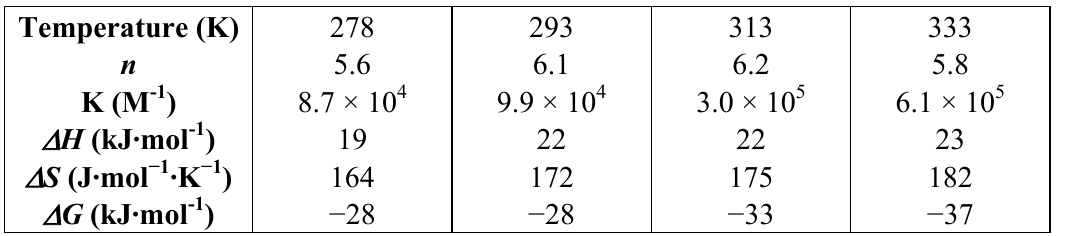
Table 1. Thermodynamic parameters obtained for the